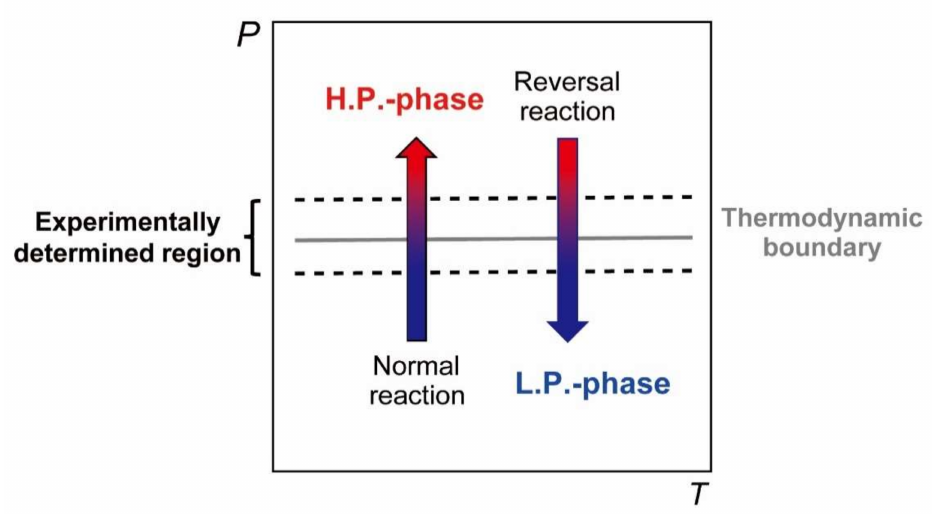
Figure 1. Determination of a phase transition pressure between low pressure (L.P.)- and high pressure (H.P.)-phases based on the principle of phase